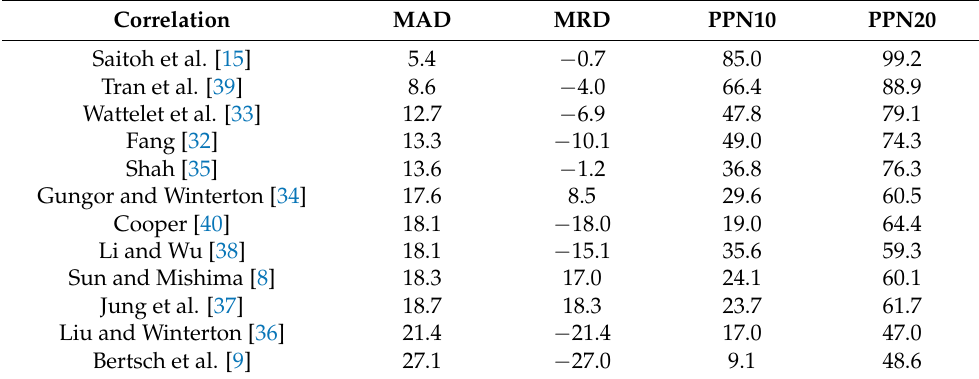
Table 3. Prediction deviations of the existing HTC correlations